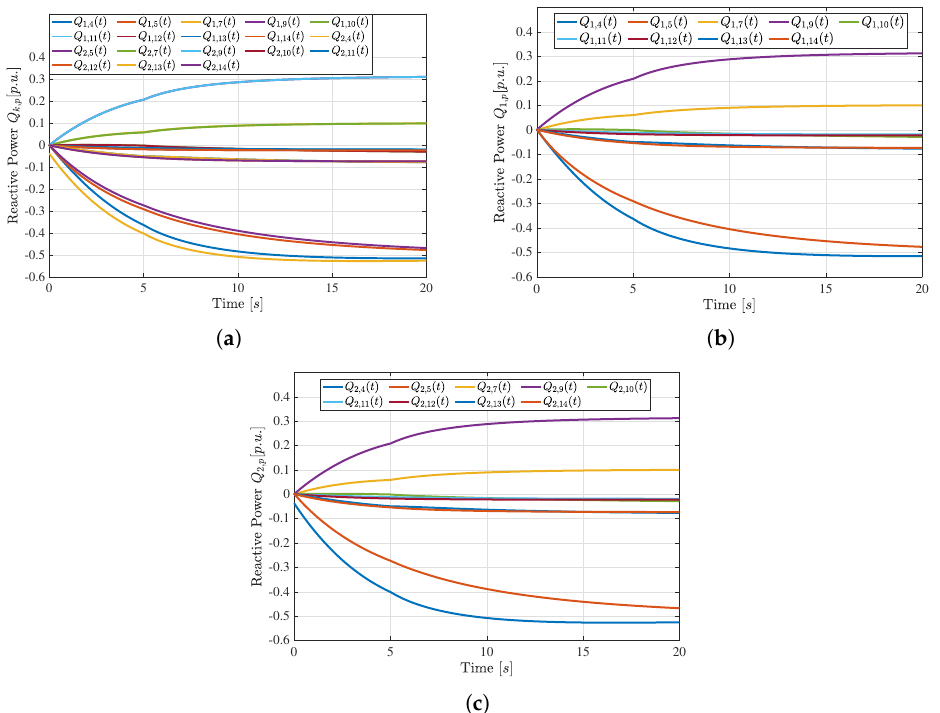
Figure 4. Cluster Oriented Double Layer Cooperative Control in Nominal scenario . Time history of: ( a ) Reactive power of the MMGs Q k , p , k = 1,2, p ∈ N k c [ p . u . ] ; ( b ) MG 1 Capacitor bank bus Reactive power Q 1, p , p ∈ N 1 c [ p . u . ] ; ( c ) MG 2 Capacitor bank bus Reactive power Q 2, p , p ∈ N 2 c [ p . u . ]